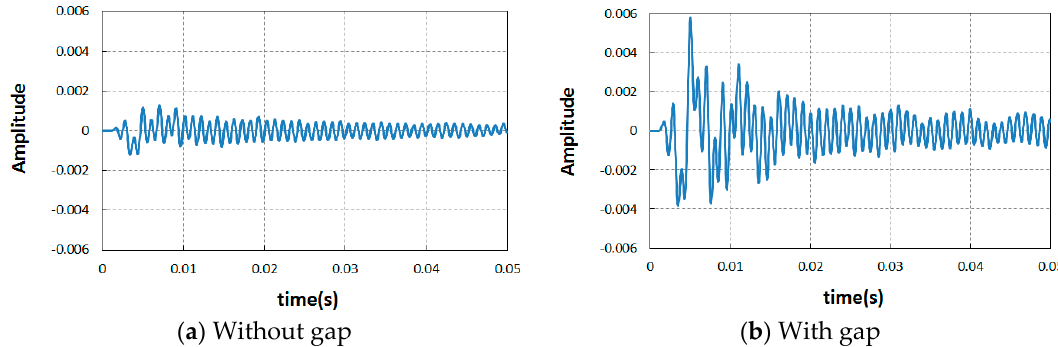
Figure 3. Comparison of acceleration amplitudes on the concrete surface between without gap and with gap cases in time domain. ( a ) Without gap. ( b ) With gap.